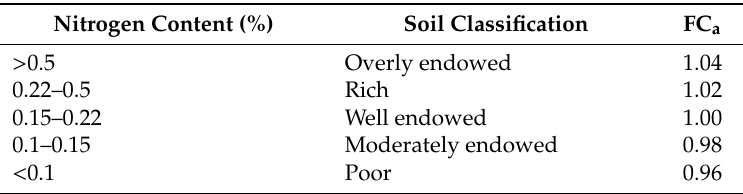
Table 2. Control classes for the soil nitrogen content (CF a ).